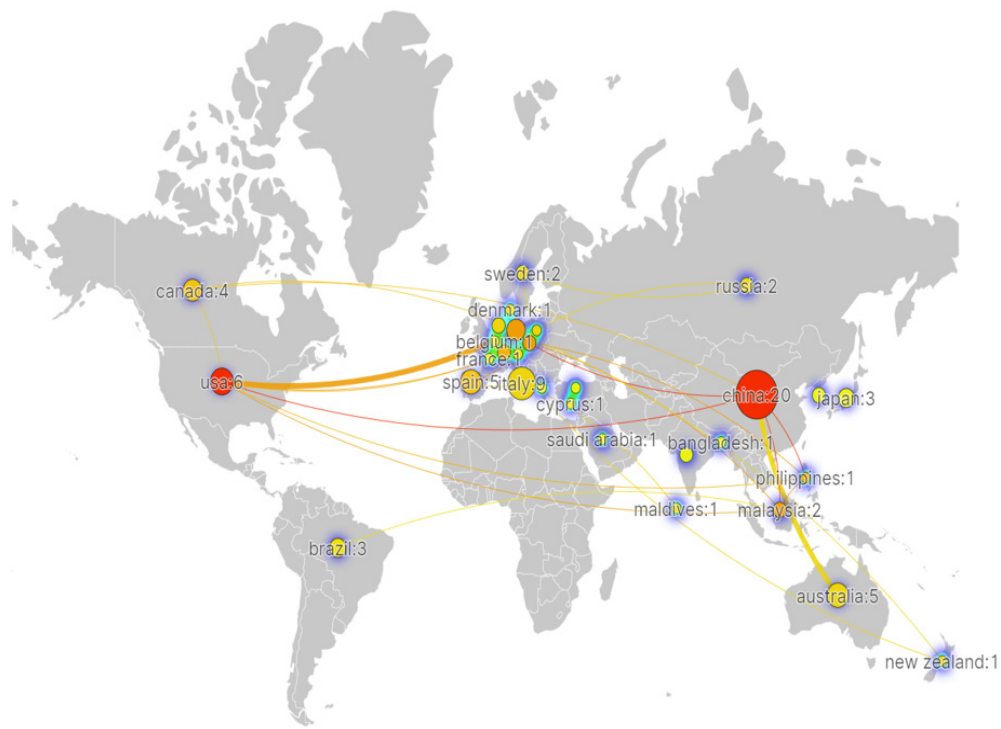
Figure 8. Collaboration network of countries/regions (visualized with Scimago Graphica).